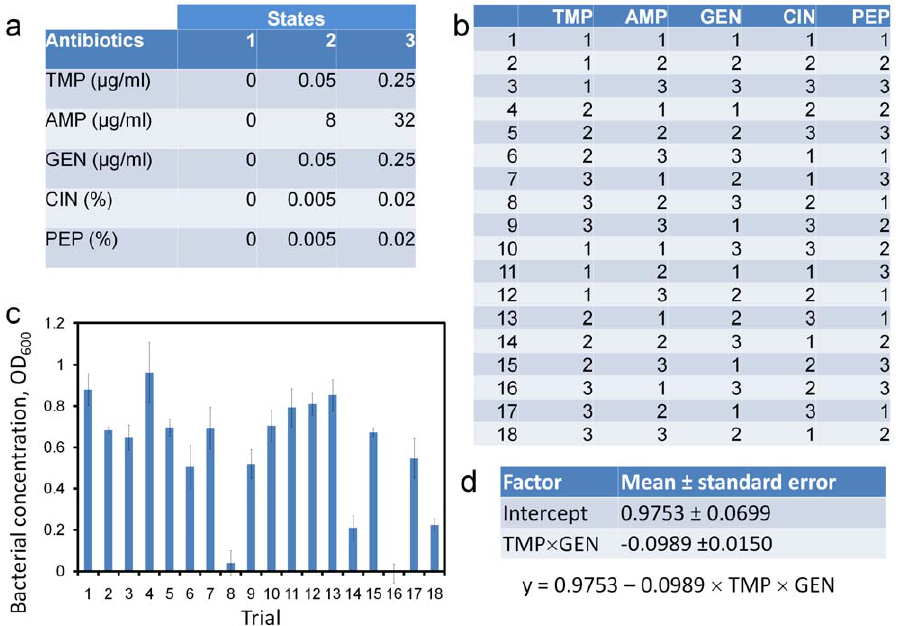
Figure 3. A 5-drug screening experiment using the MACO scheme. (a) Three concentration levels for each antibiotic are assigned. (b) Fractional factorial experimental design for the five antibiotics. 18 experimental trials are required. (c) Bacterial growths with the antibiotic cocktails described in (b). (d) Result of the regression analysis based on the factorial regression and quadratic response surface models. SMX=sulphamethoxazole; CIN=cinnamon oil; PEP=peppermint oil.